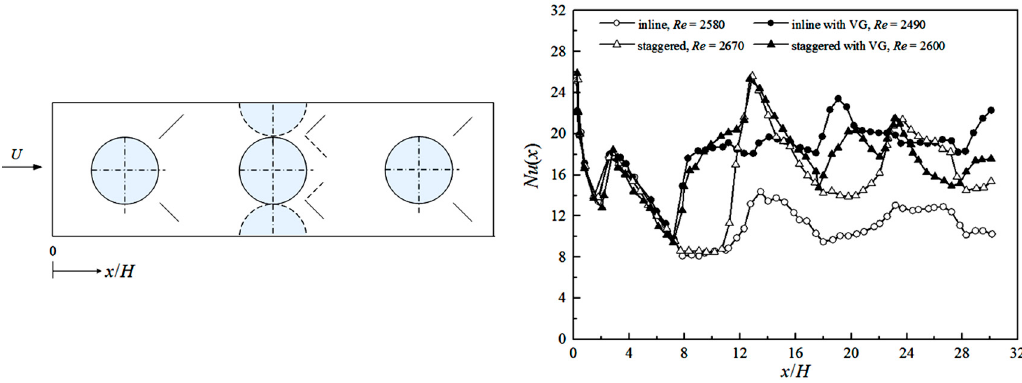
Figure 8. Span-averaged Nu number for various configurations [27].